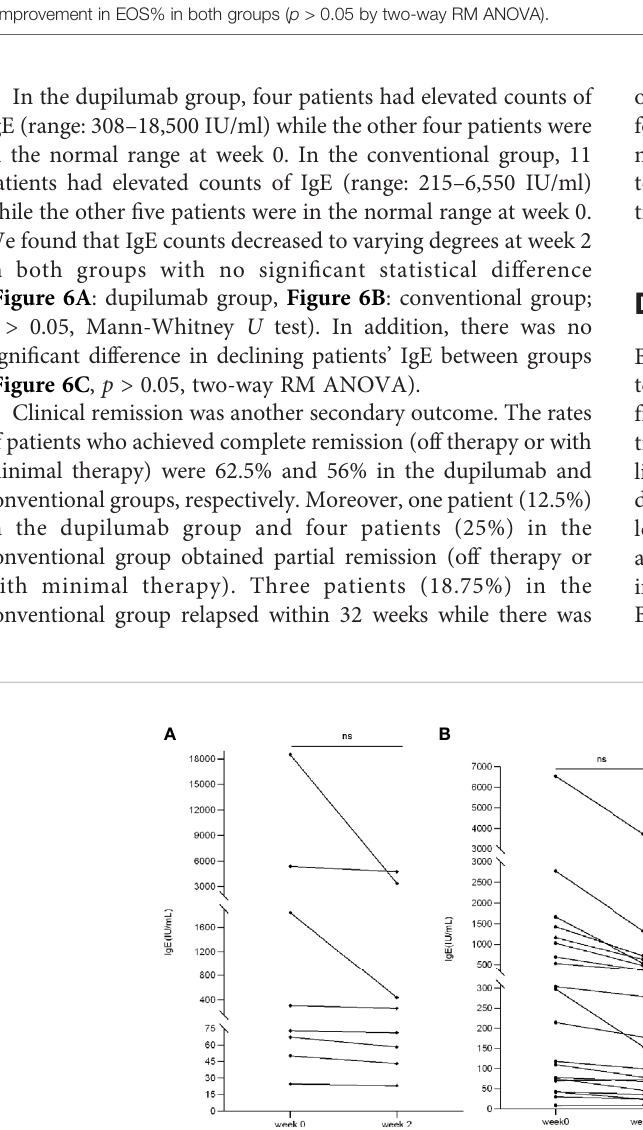
FIGURE 6 | Comparison of IgE between two treatment groups. IgE has decreased to varying degrees from weeks 0 to 2 in the dupilumab group (A) (ns, not signi fi cant; p > 0.05 by Mann-Whitney U test) and the conventional group (B) (ns, not signi fi cant p > 0.05 by Mann-Whitney U test). (C) Comparison of improvement in IgE in both groups ( p > 0.05 by two-way RM